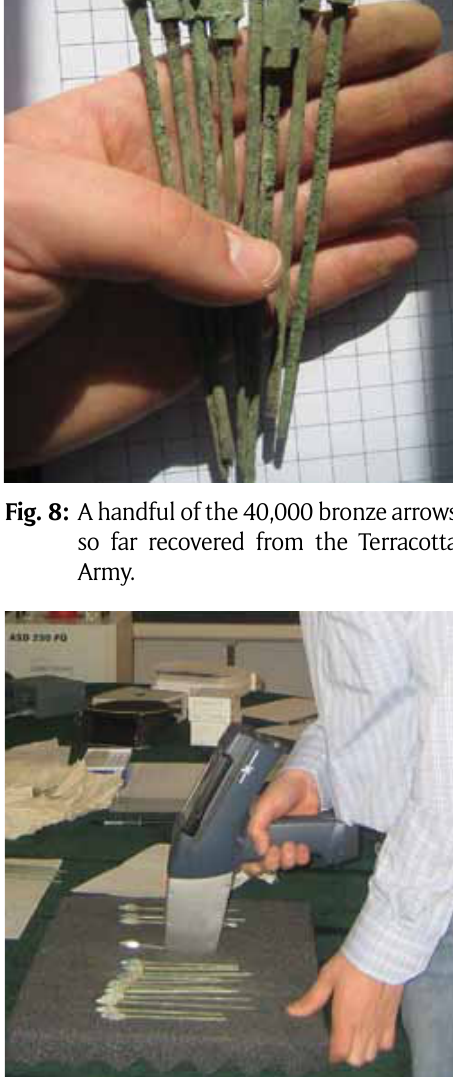
Fig. 9: Analysis of bronze weapons using a portable